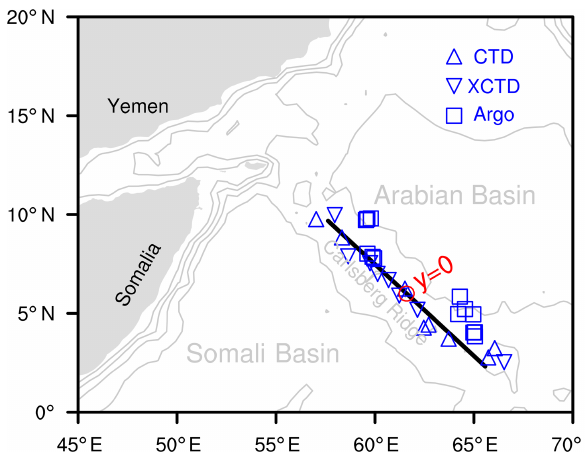
Table 1. Information on CTD/XCTD stations and Argo